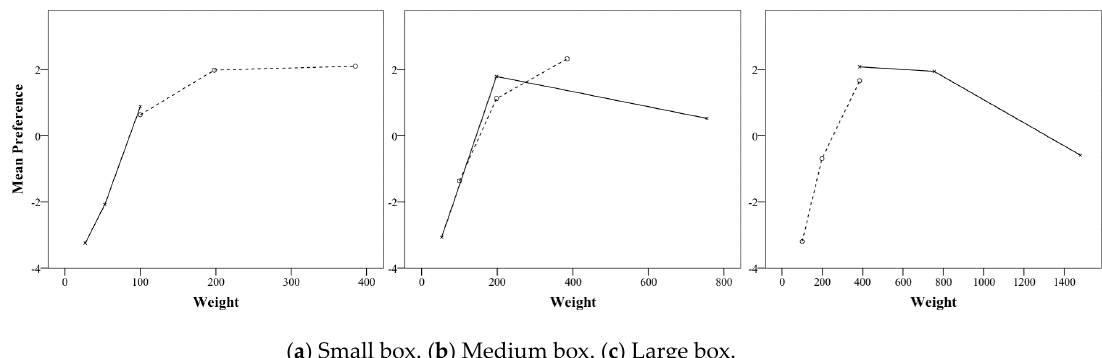
Figure 7. Mean preference of weights for each box size (the dashed line is the first experiment, and the solid line is the second